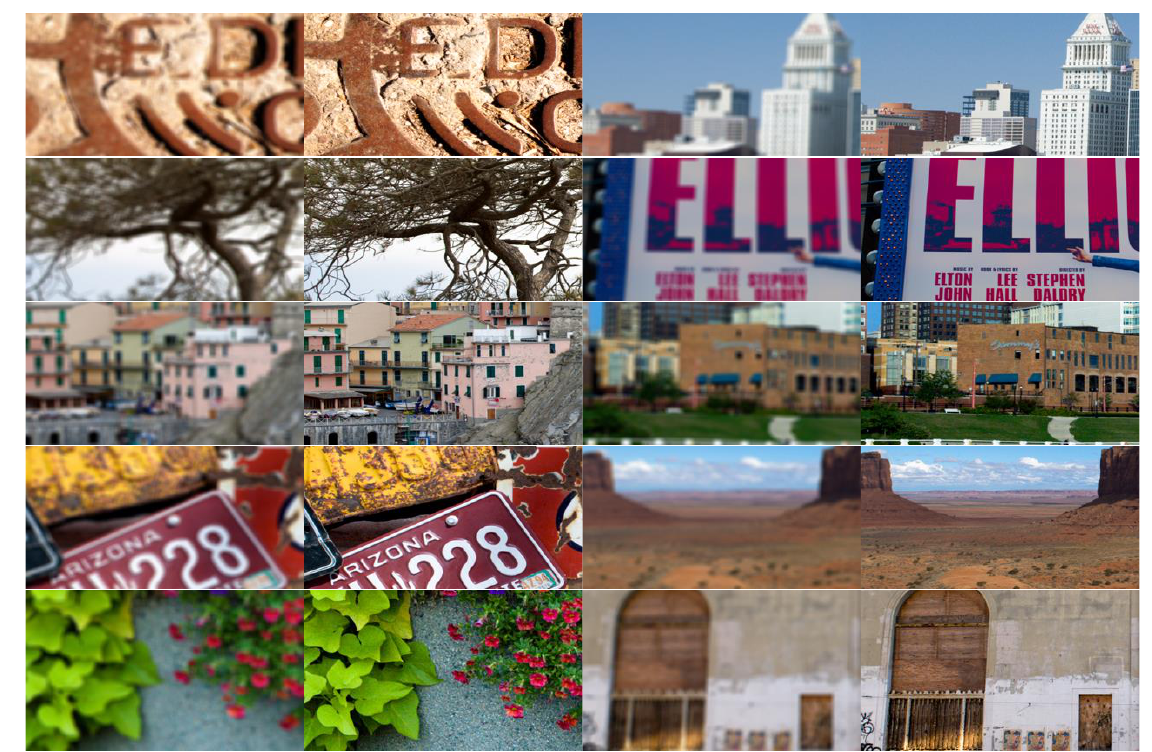
Figure 4. Part of data set based on CODE V